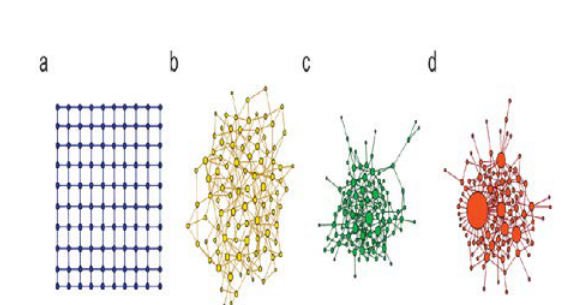
Figure 1: The four different kinds of network topology of forests: a: regular; b: random; c: exponent; d: scale free. Every node represents as a forest patch and link line as a